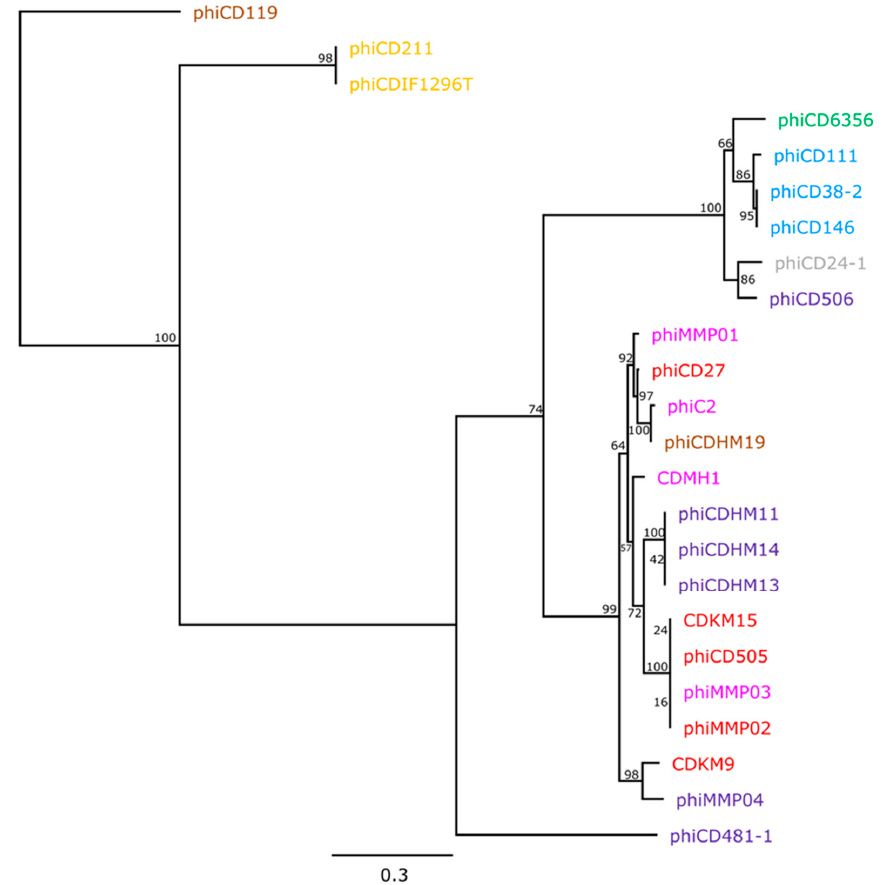
Figure 6. Maximum likelihood phylogenetic analysis of C. difficile phage endolysins. Tree node labels represent bootstrap values.